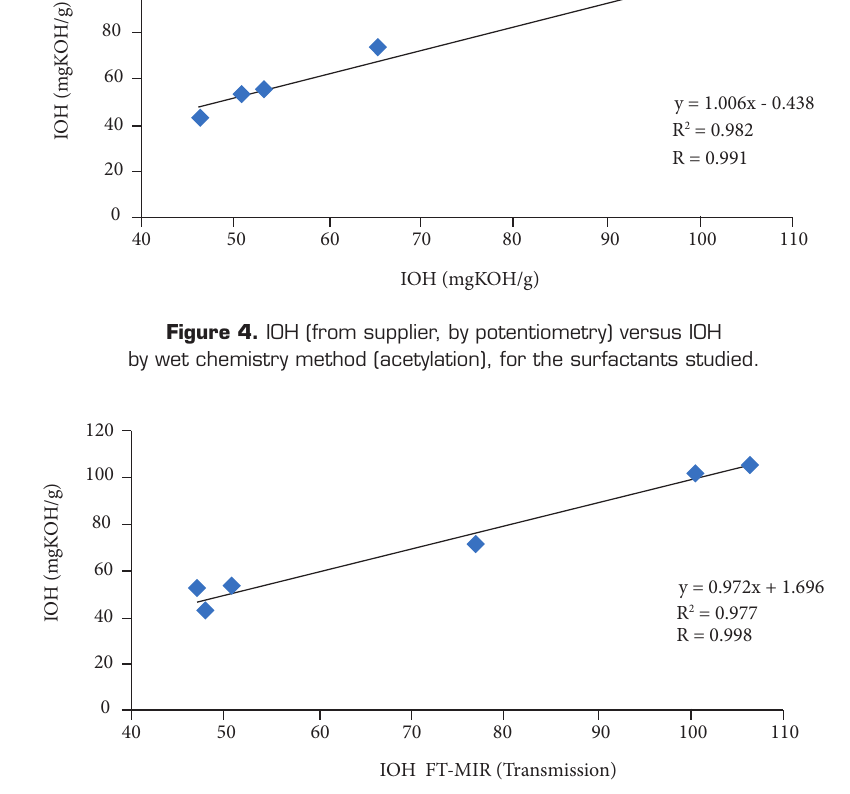
Figure 5. IOH (from supplier, by potentiometry) versus IOH measured by FT-MIR (transmission), for the surfactants studied.